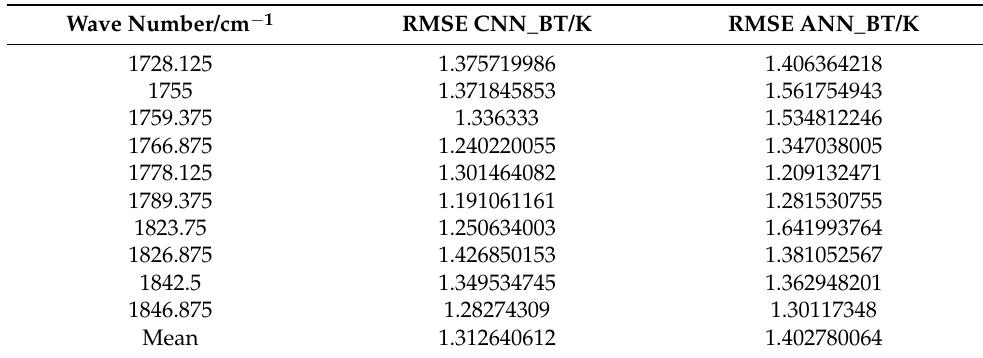
Table 2. Comparison of the RMSEs of CNN_BT and